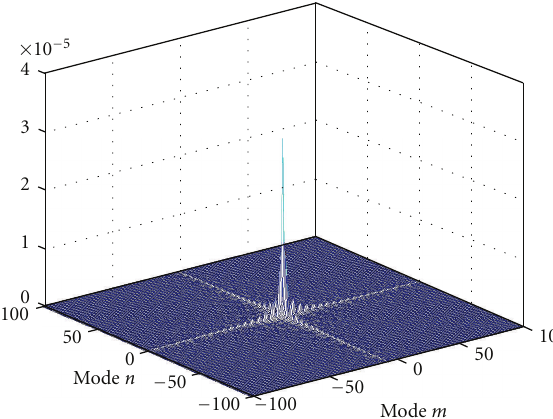
| of the 2D periodic square patch shown in Figure 5: | Λ m , n ,0,0 ap Figure